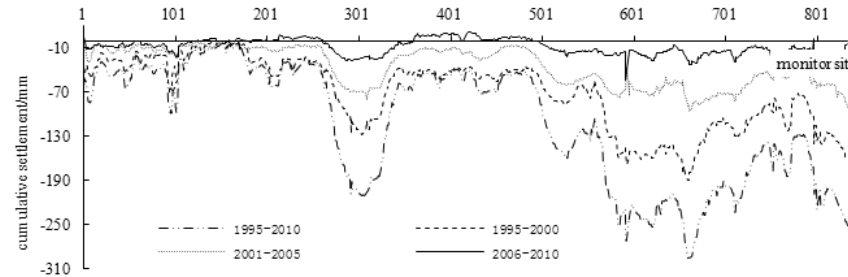
Figure 1. Graph of cumulative settlement of A in different periods